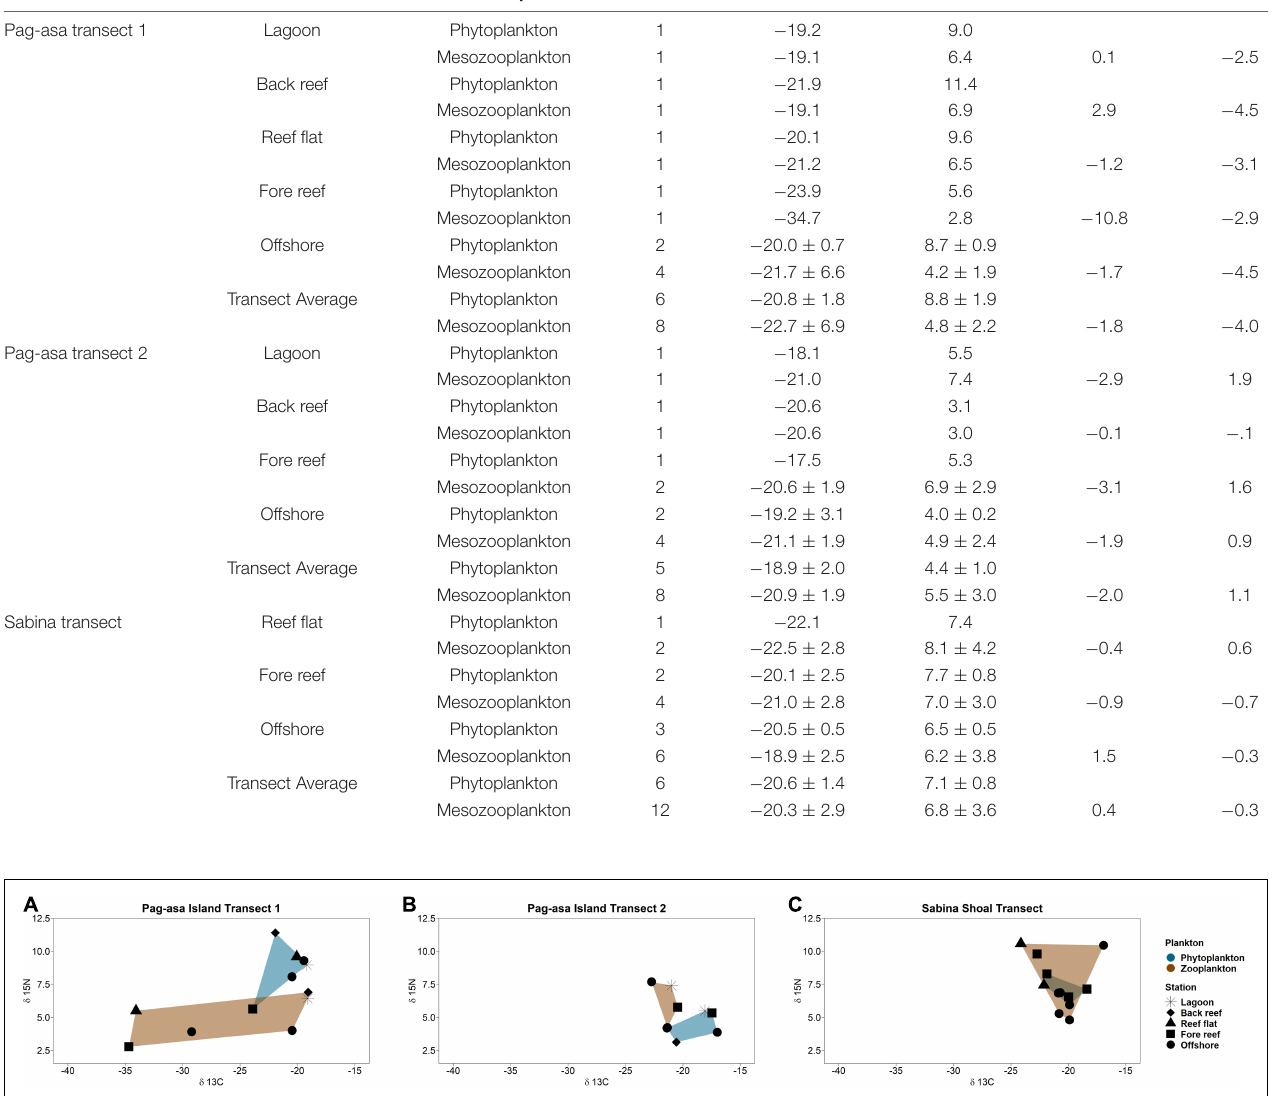
FIGURE 8 | δ 15 N: δ 13 C biplot with convex hulls per transect: (A) Pag-asa Island Transect 1, (B) Pag-asa Island Transect 2, and (C) Sabina Shoal Transect. Symbols represent different reef zones. Blue-yellow hulls represent phytoplankton samples, while brown hulls represent